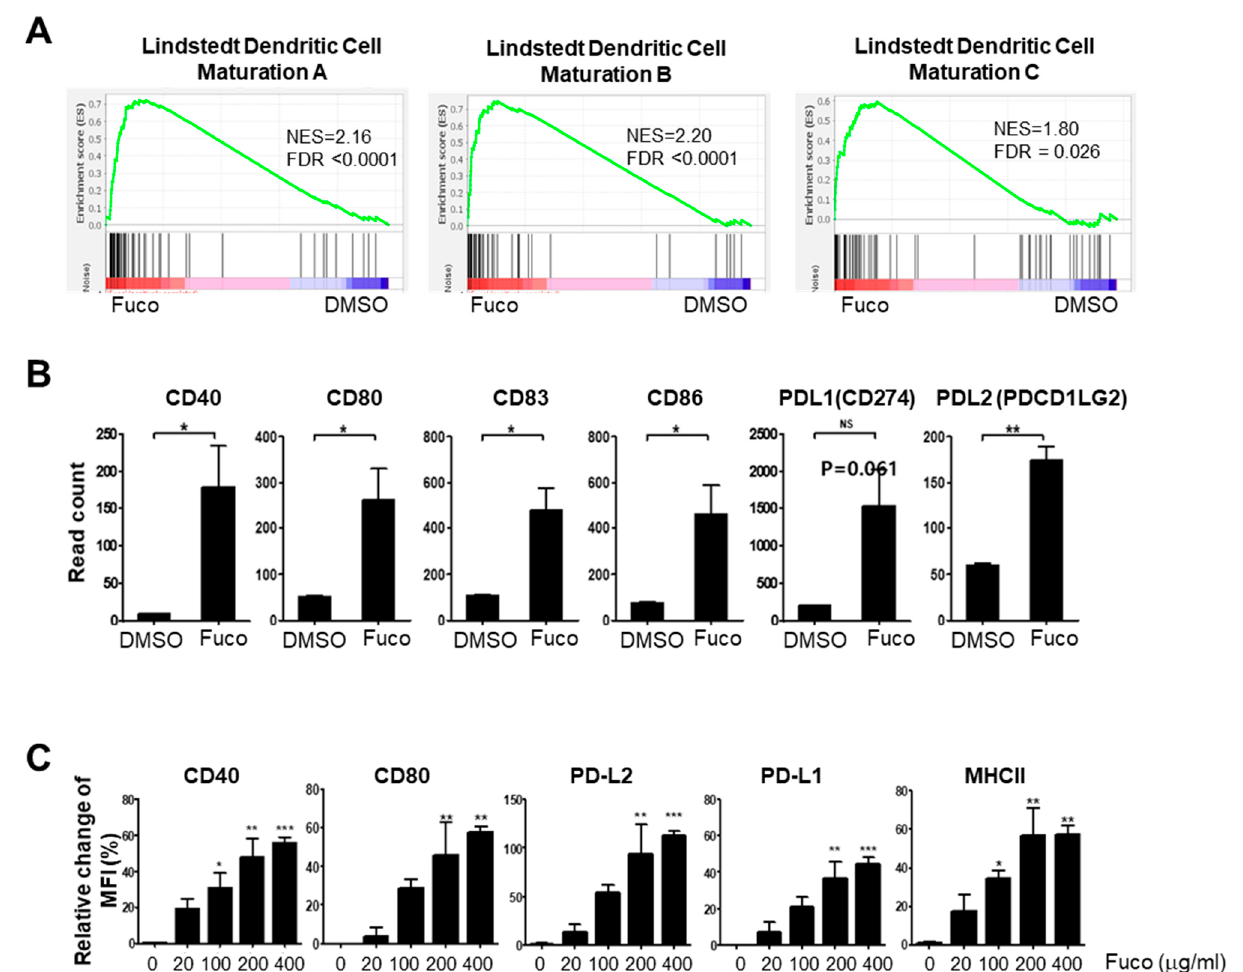
Figure 5. Fucoidan activates maturation of BMDCs. ( A ) Enrichment plots of Lindstedt DC maturation gene sets showing significant upregulation in fucoidan-treated BMDC. ( B ) Read counts of the DC maturation markers by RNA-seq. ( C ) Flow cytometry of DC maturation markers in fucoidan-treated BMDCs. Statistical difference by using the unpaired t -test relative to vehicle ( B ) or, one-way ANOVA with Dunnett’s post-test analysis compared to stained control (0 µ g/mL) ( C ). The bar above the data displays ± SEM. Asterisks depict levels of significance as follows: NS, not significant ( p ≥ 0.05); * p < 0.05; ** p < 0.01; *** p < 0.001.